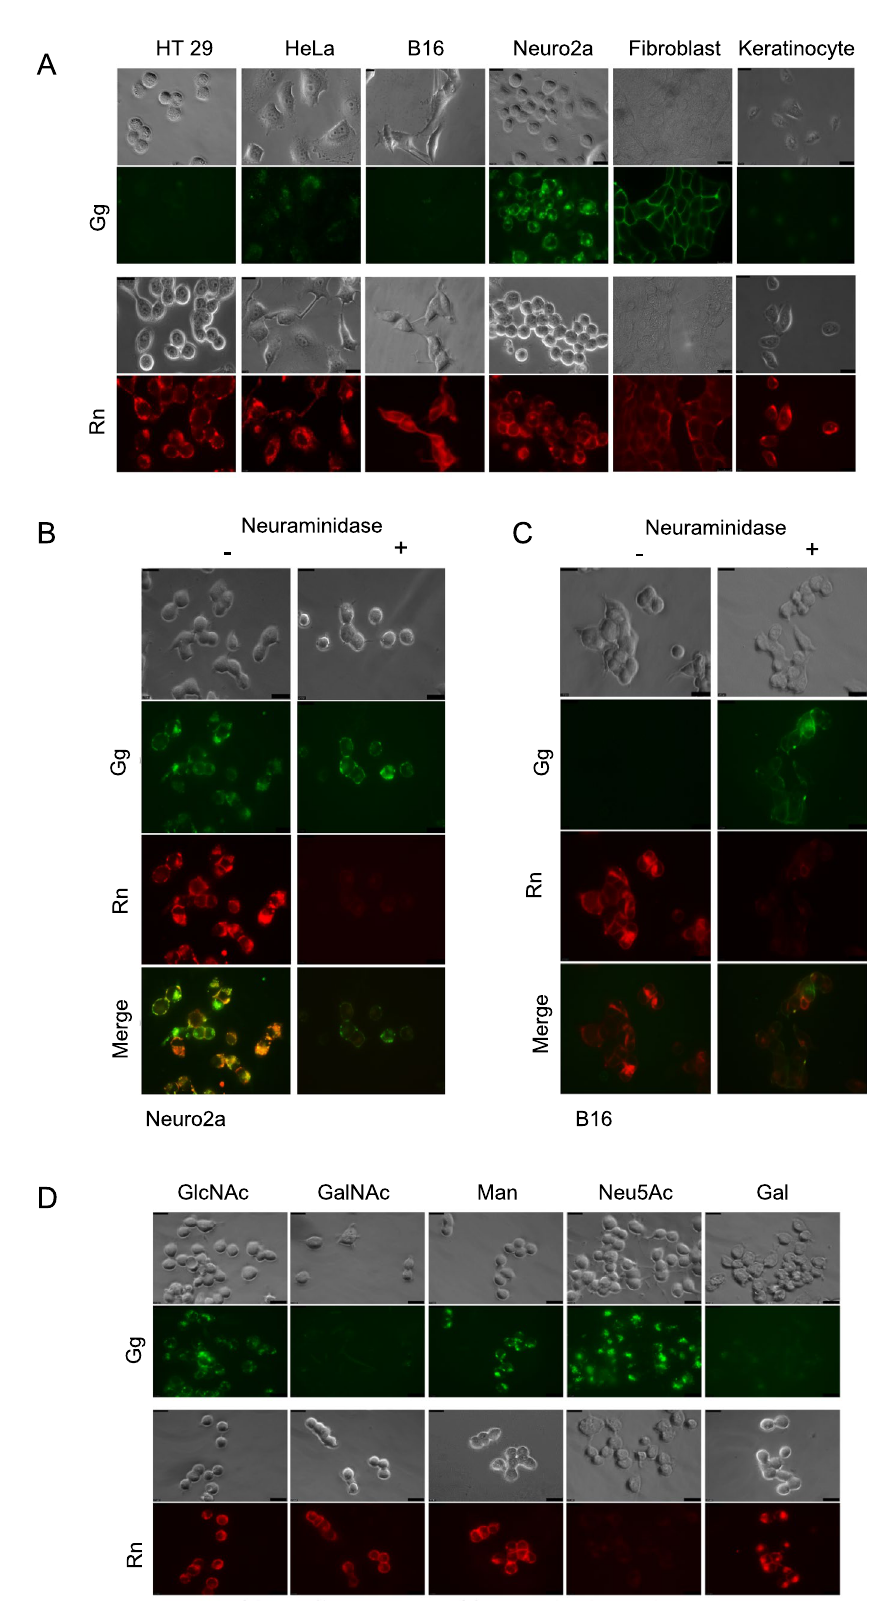
Figure 5. Confirmation of binding specificity of Gg and Rn on cells. (A) Bright field and fluorescence images of Neuro2a cells stained with Gg and Rn with and without neuraminidase. ( B ) Bright field and fluorescence images of B16F10 cells stained with Gg and Rn with and without neuraminidase. ( C ) Bright field and fluorescence images of Neuro2a cells stained with Gg and Rn in the presence of various sugars that can inhibit binding activity of lectin complex. Galactose and N -acetylgalactosamine inhibits binding of Gg while N -acetylneuraminic acid inhibits binding of Rn. Scale bars: 10